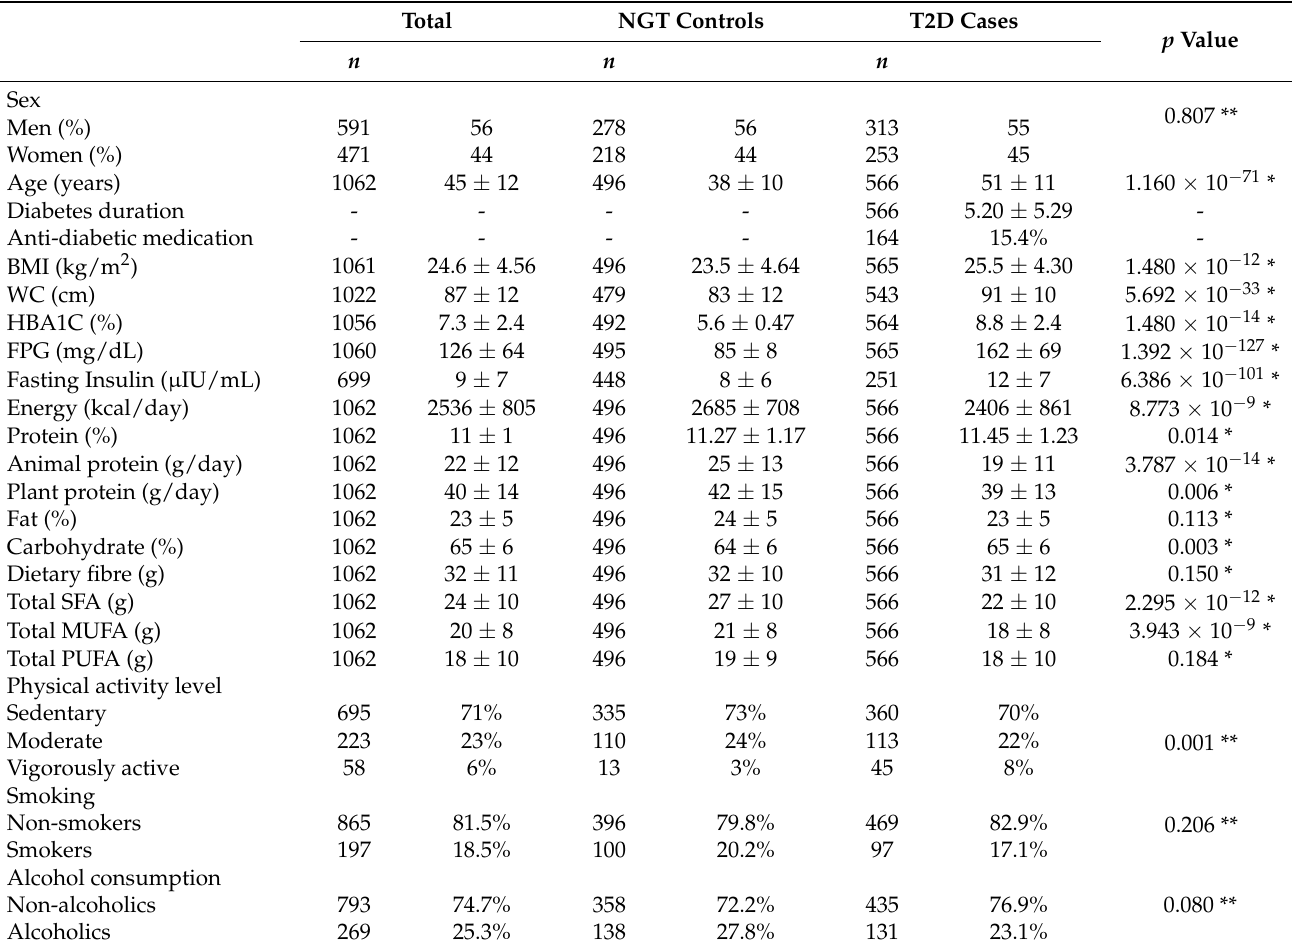
Table 1. Characteristics of study participants.